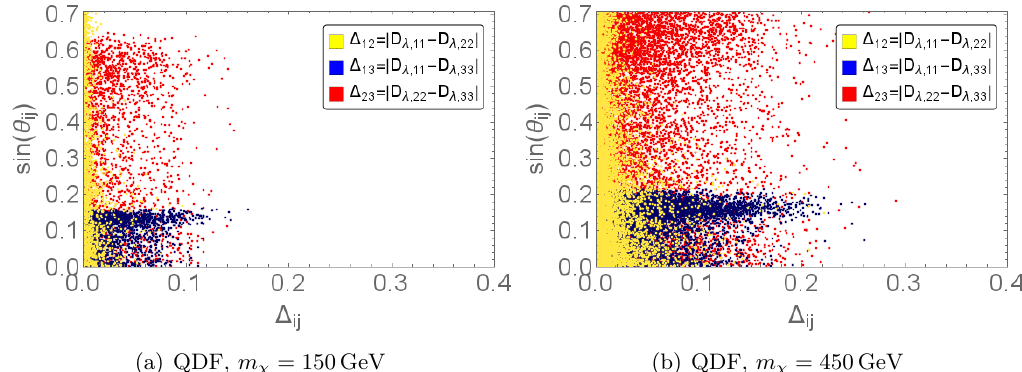
Figure 7 . Viable regions of parameter space of the quark doublet DMFV model, with combined (cid:13)avour, relic abundance and direct detection constraints applied, for QDF scenario and di(cid:11)erent DM masses, with m (cid:30) = 850 GeV and (cid:17) = (cid:0) 0 : 01. Di(cid:11)erent colours correspond to the di(cid:11)erent mixing angles (cid:18) ij and splittings j D (cid:21);ii (cid:0) D (cid:21);jj j = (cid:1) ij , with each colour representing one pair of indices: ij = 12 in yellow, ij = 13 in blue, ij = 23 in